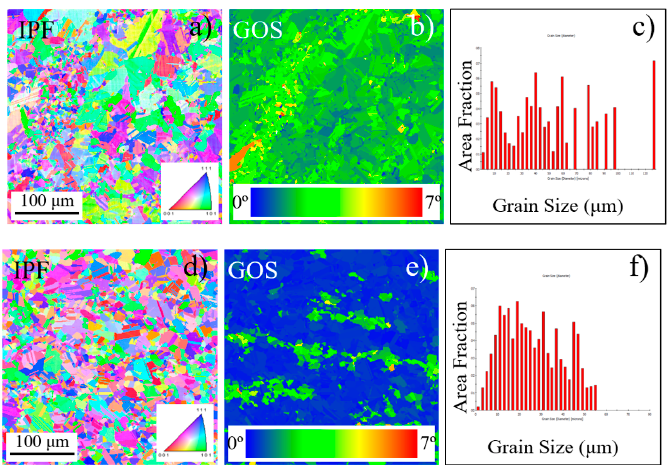
Figure 4. Electron back-scattered diffraction (EBSD) images of annealed and aged Inconel 718: ( a – c ) annealed material, ( d – f ) aged material. Table 3. Physical properties of Inconel 718 before and after heat treatment.